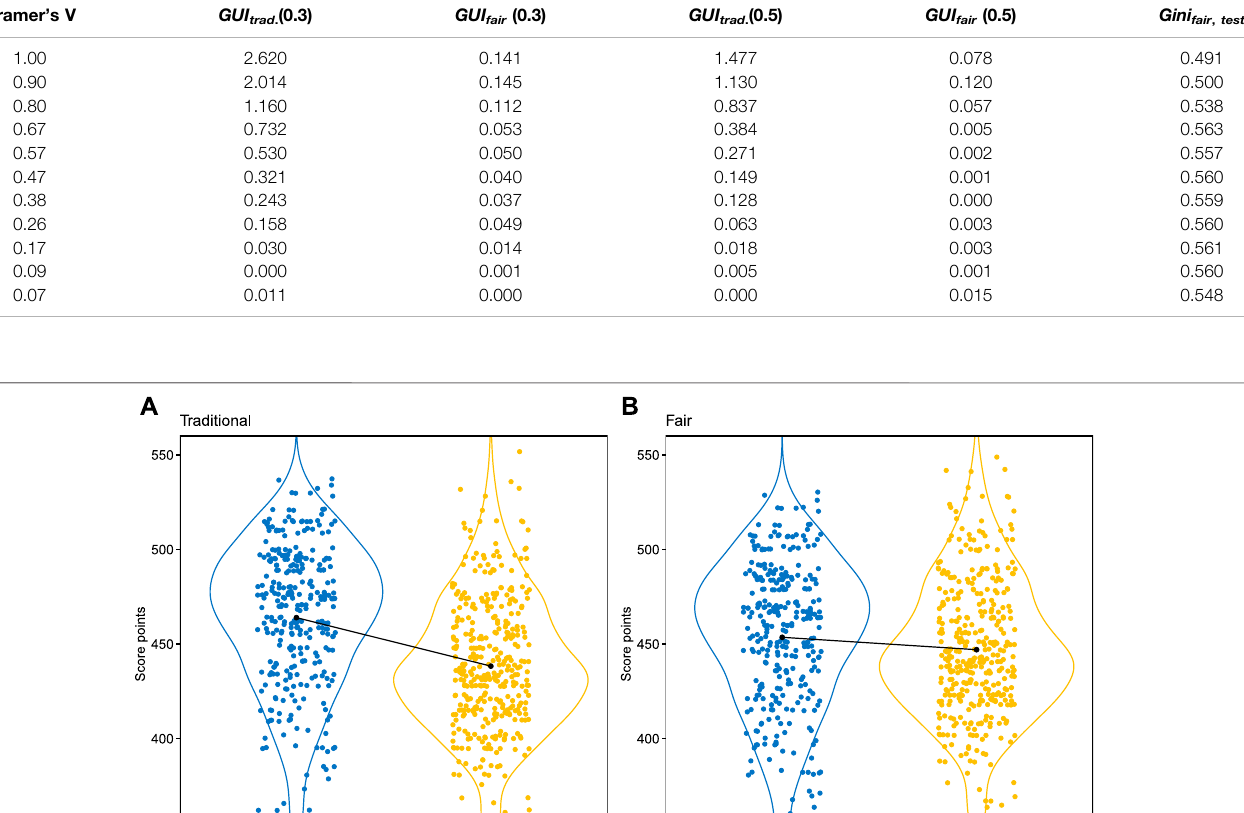
some of the simulated data sets the fair model even slightly small number of observations in the data resulting in a large 95 % (bootstrap) con fi dence interval (Robin et al., 2011) of (0.437,0.667) and only small performance decrease due to the fairness correction. The corresponding dashed lines show the group unfairness index of